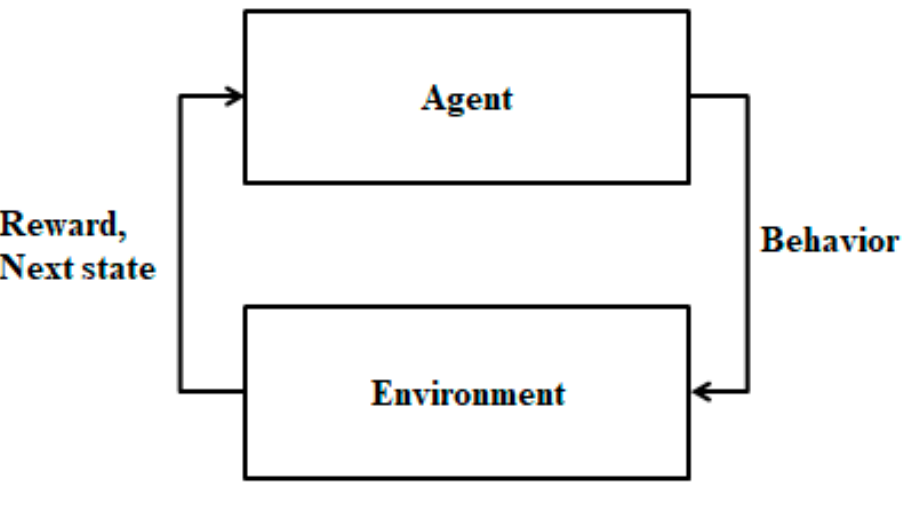
Figure 1. Reinforcement learning.